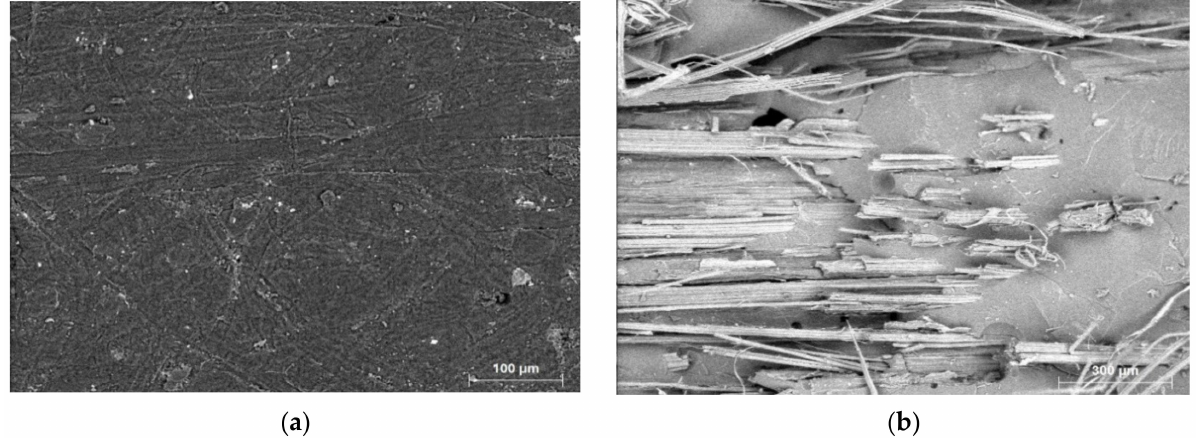
Figure 12. SEM micrographs of single sisal fiber composite (0C/40S) ( a ) surface and ( b ) fractured position.